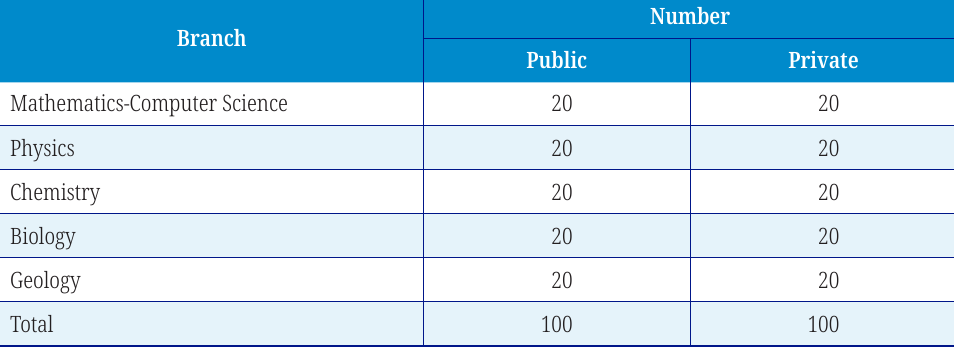
Table 1. Distribution of the sample of institutions (private/public) in relation to streams